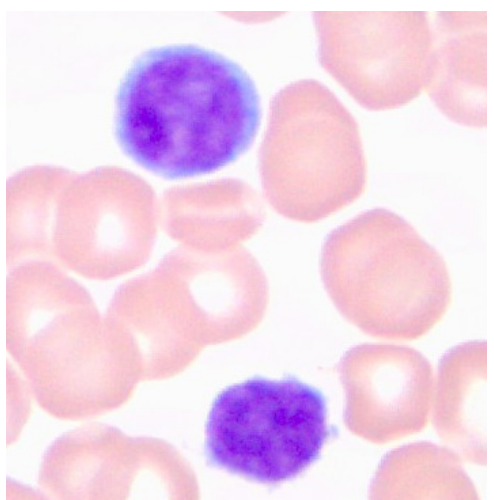
Fig. 10. Special lymphocyte without cytoplasm (the bottom one).